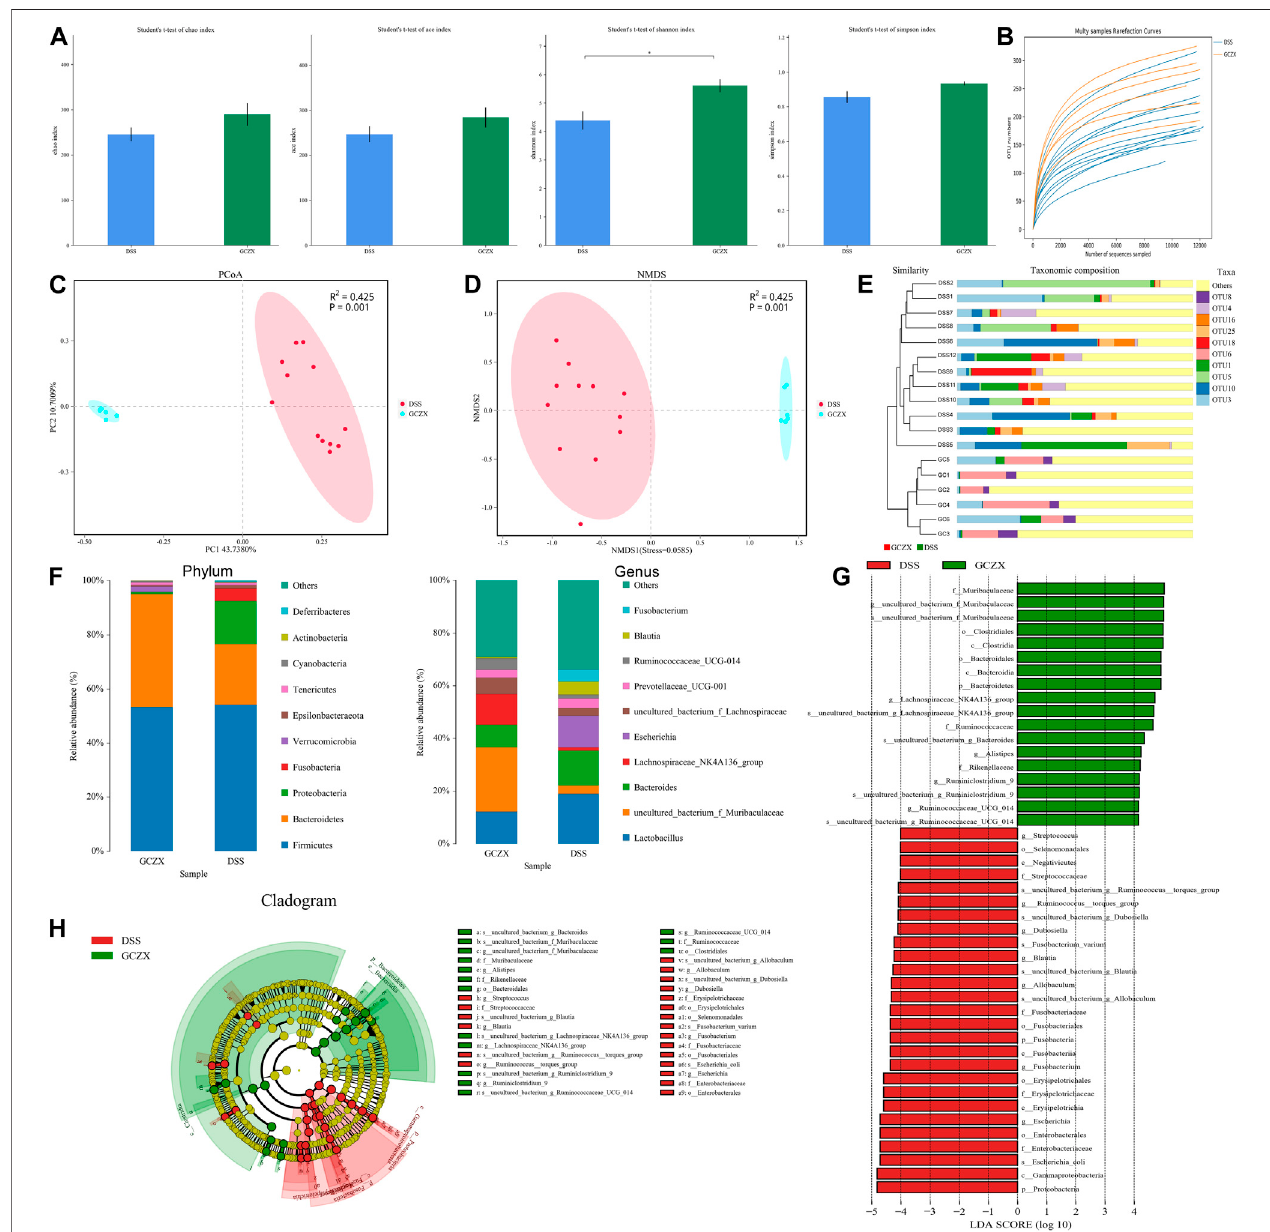
FIGURE 6 | Pro fi les of microbial communities with GCZX treatment Altered Alpha-diversity of microbiota (A) , rarefaction analysis (B) , PoA (C) , and NMDS (D) as well as UPGMA (E) illustrating the clustering of gut fl ora between UC and GCZX-treated UC mice; Microbiota composition at the phylum and genus levels after GCZX therapy (F) ; Cladogram (H) and LEFSe (G) illustrating the abundance of bacterial species between UC and GCZX-treated UC mice.